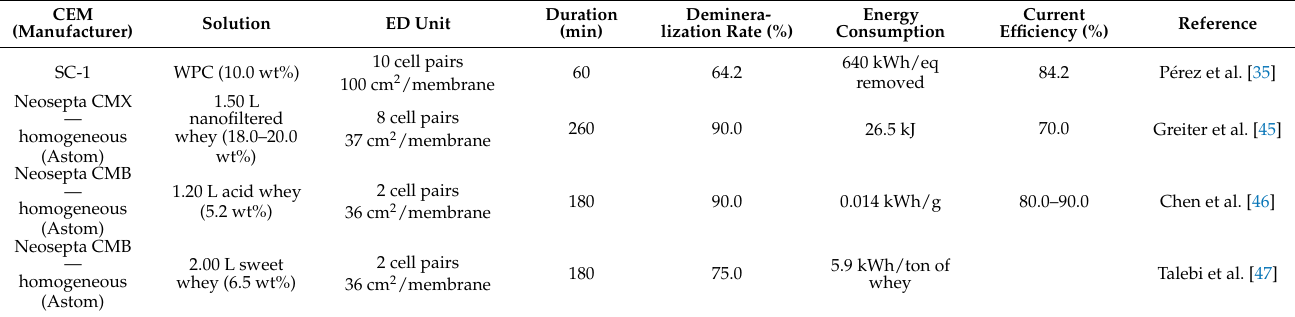
Table 7. Performances of alternative CEMs on dairy product applications reported in the literature.